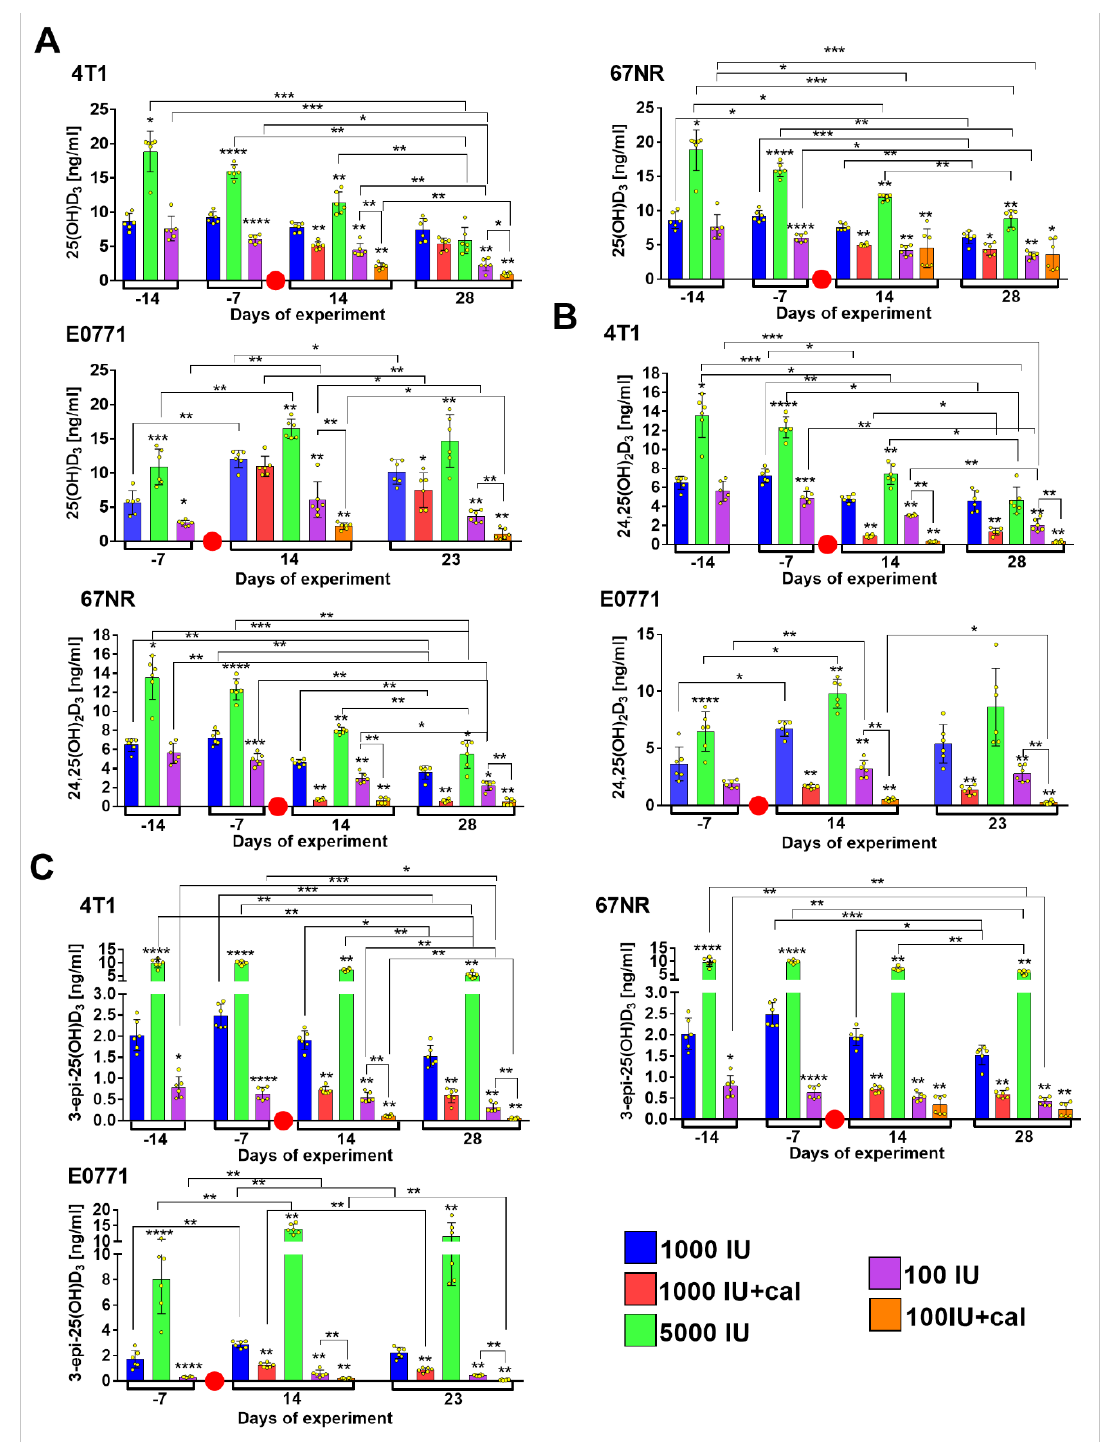
Figure 5. Kinetics of vitamin D metabolite plasma level in mammary gland tumor-bearing BALB/c and C57BL/6 mice. ( A ) 25(OH)D 3 , ( B ) 24,25(OH) 2 D 3 , and ( C ) 3-epi-25(OH)D 3 plasma levels in mice bearing 4T1, 67NR (BALB/c), and E0771 (C57BL/6) mammary gland cancer. A red circle separates the measurements taken before the tumor implantation from those taken after the implantation. Data presented as mean with standard deviation; individual data are also presented as yellow points. Plasma from 6 mice/group was analyzed. Statistical analysis: Dunn’s test for multiple comparisons or Mann–Whitney test. * p < 0.05; ** p < 0.01; *** p < 0.001; **** p < 0.0001.